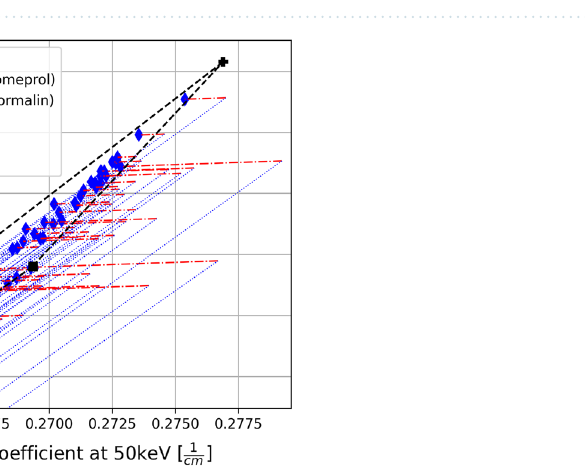
Figure 3. ( a ) Virtual monoE images of one measured clot at 50keV and ( b ) 200keV. ( c ) Illustration of the iomeprol as well as formalin correction using scatter plots and ( d ) magnification to the area visually representing the error between the optimized point and the value measured on the DE-CT. Using the basis material attenuation of fibrin/platelets, RBC, and WBC as well as the results of the histological analysis, a histological result is plotted in the scatter plot for each specimen. Starting from this point, the algorithm corrects the histological result point by the iomeprol and formalin concentrations along the vectors characteristic for each specimen (optimization paths). The algorithm then reaches its optimum as soon as the distance between the optimized point and the measured specimen point is minimal. The triangle boarder line indicates the enclosed area within which a specimen consisting exclusively of the three base materials can lie.